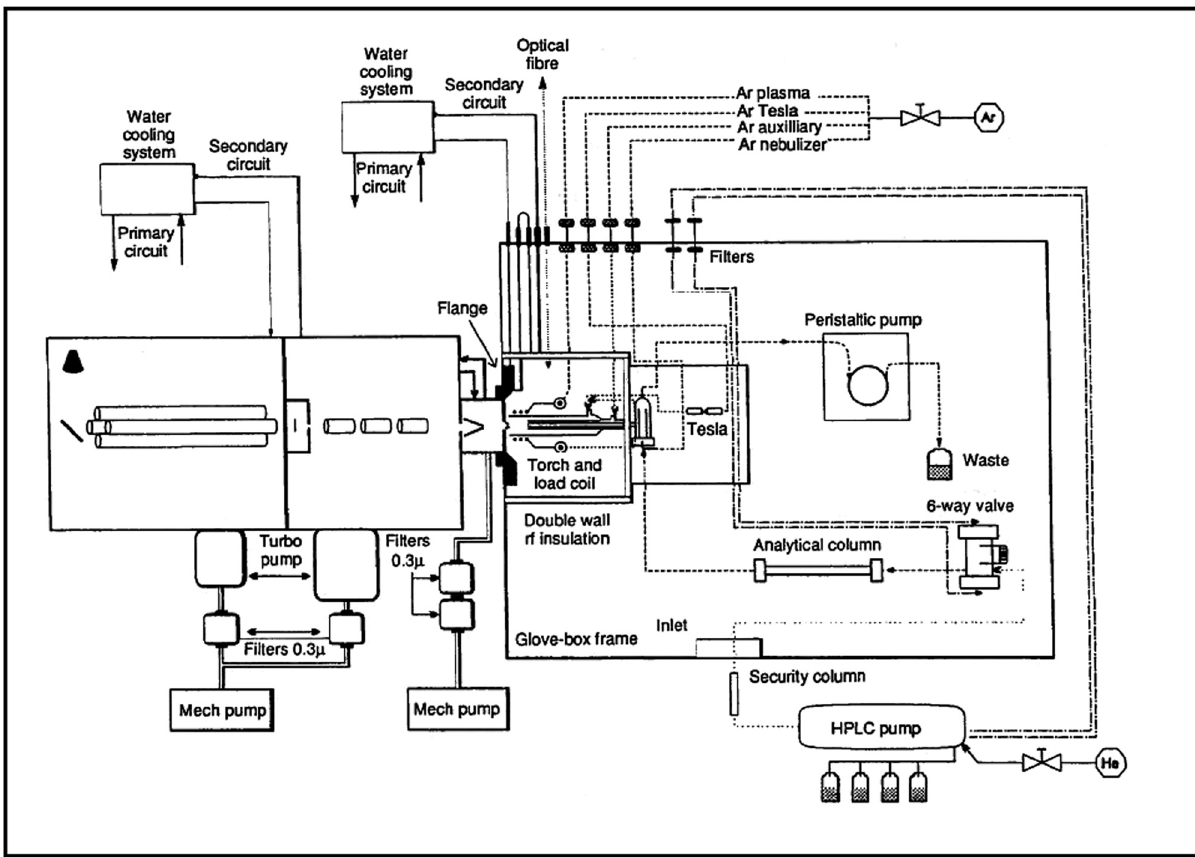
Figure 2: Schematic diagram of IC - ICP - MS coupled analytical set up with glove box ( reproduced from ref. [ 57 ] with permission from The Royal Society of Chemistry )